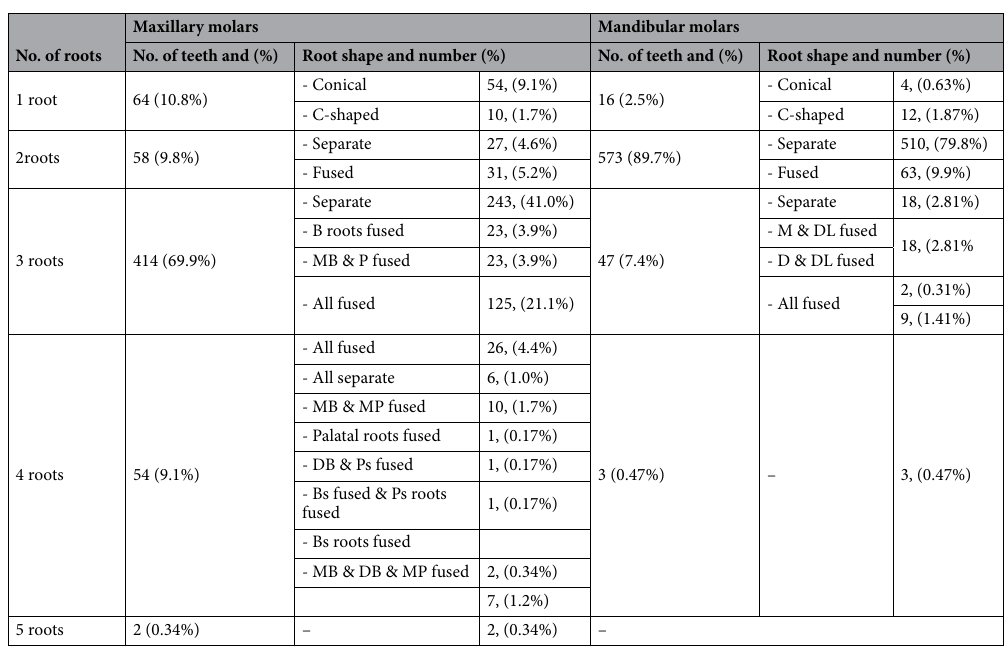
Table 1. Classification of maxillary and mandibular third molars according to root number and morphology.